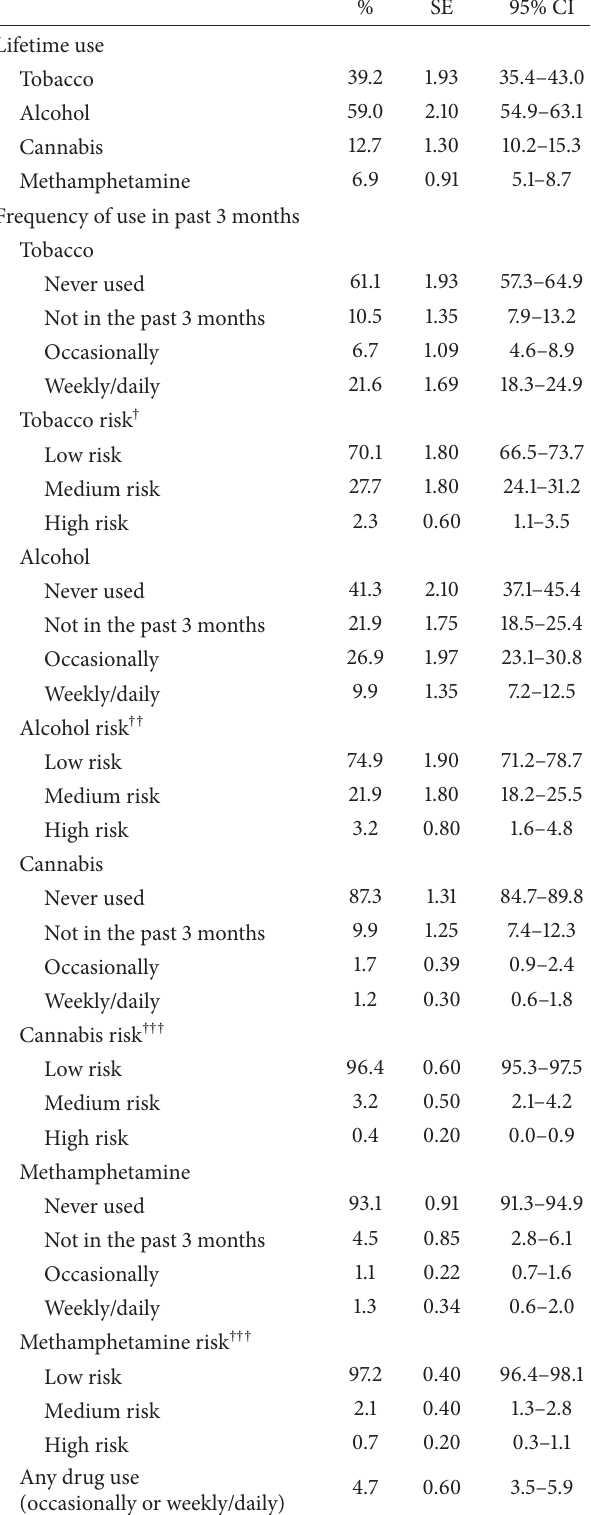
Table 3: Alcohol, Smoking, and Substance Involvement Screening Test (ASSIST) scores for the sub-sample (𝑛 = 684)